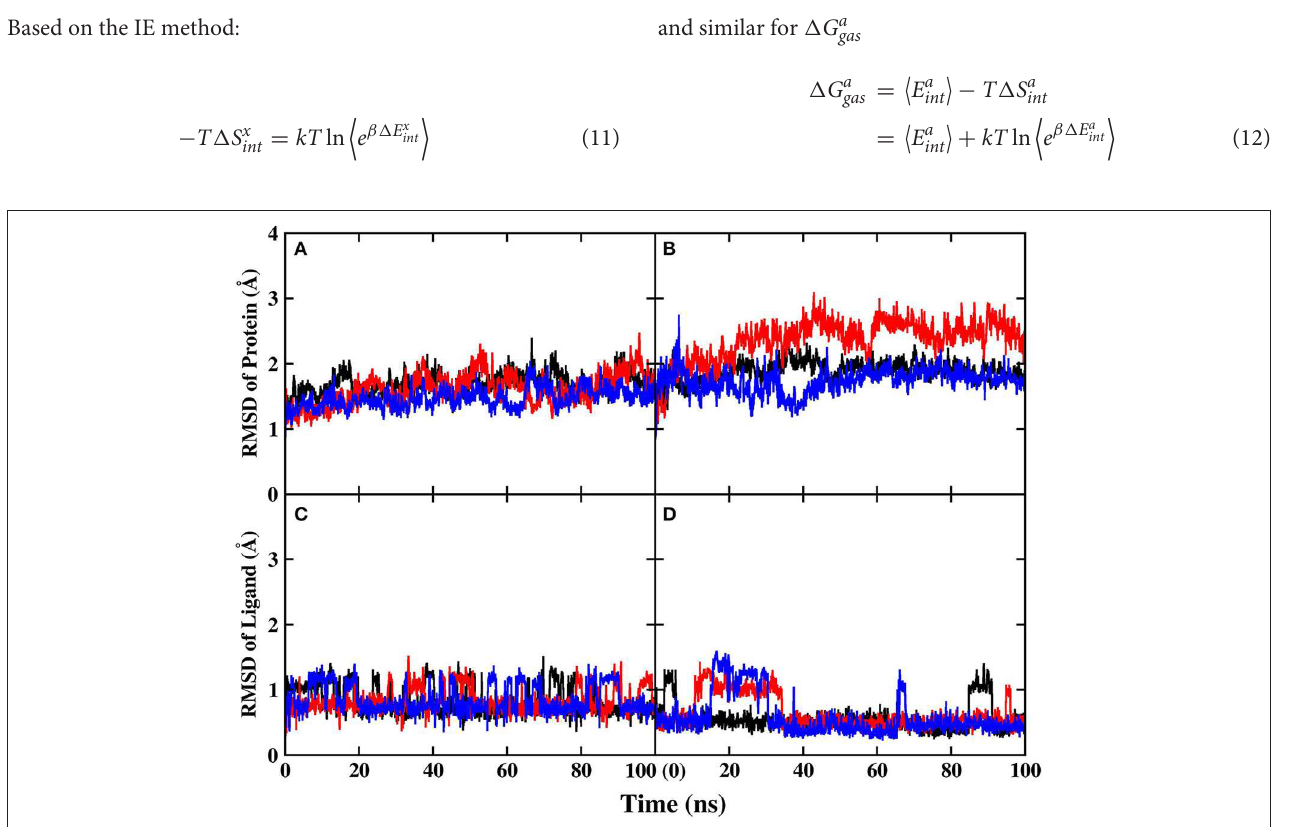
FIGURE 3 | RMSD of protein and ligand in MD simulations. Different colors represent different replicates. (A) Protein backbone in PARP-1 (B) protein backbone in PARP-2 (C) ligand in PARP-1 (D) ligand in PARP-2.